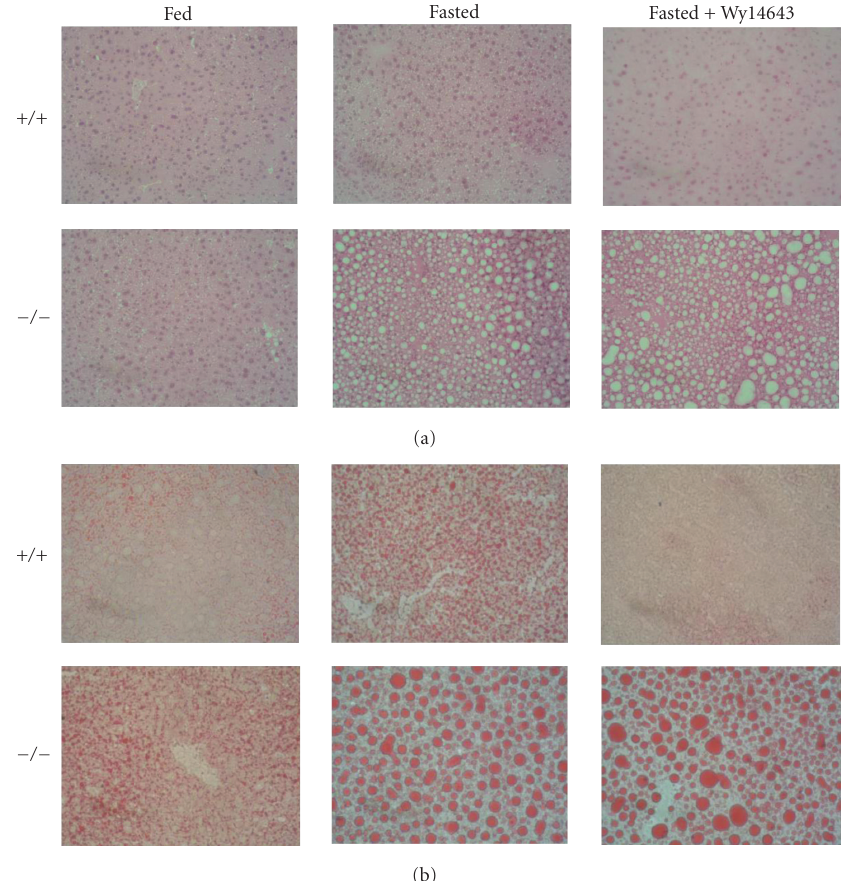
Figure 2: The PPAR α agonist Wy14643 prevents the fasting-induced increase in liver TG levels. Male wild-type and PPAR α null mice ( n = 5 per group) were given vehicle or Wy14643 for 10 days (0.1% mixed in their food). After a 24-hour fast, livers were dissected and stained histochemically using hematoxylin/eosin (a) or oil Red O (b). Representative livers sections are shown. Di ff erences visualized by histochemistry were perfectly confirmed by quantitative measurement of hepatic TG